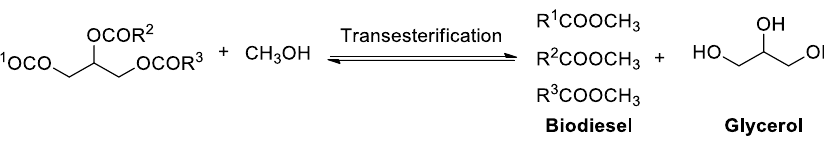
Figure 1. Biodiesel syntheses via transesterification.